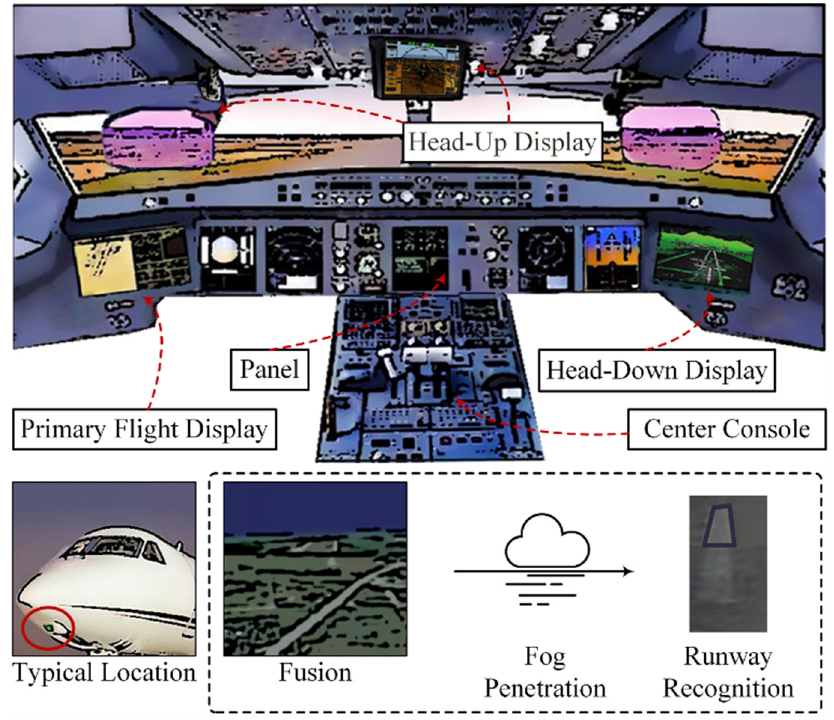
Figure 1. Diagram of the flight deck with visual instruments (The module location and quantity are not fixed in actual systems, and the figure on the lower left corner shows the installation on Gulfstream G450).